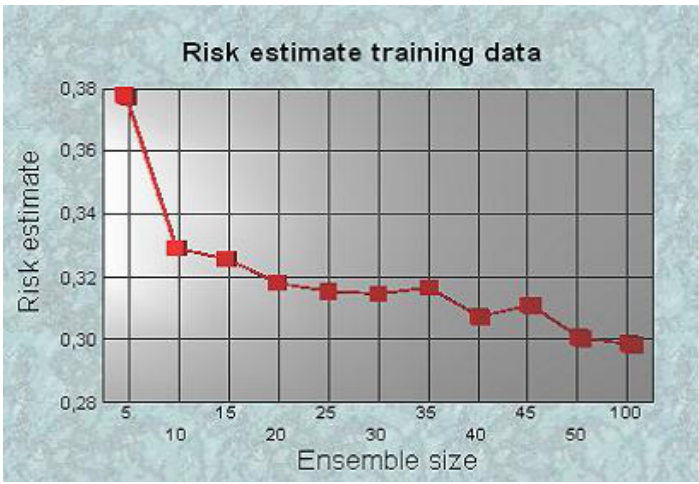
Figure 1: Relationship between ensemble size and risk estimate for training data